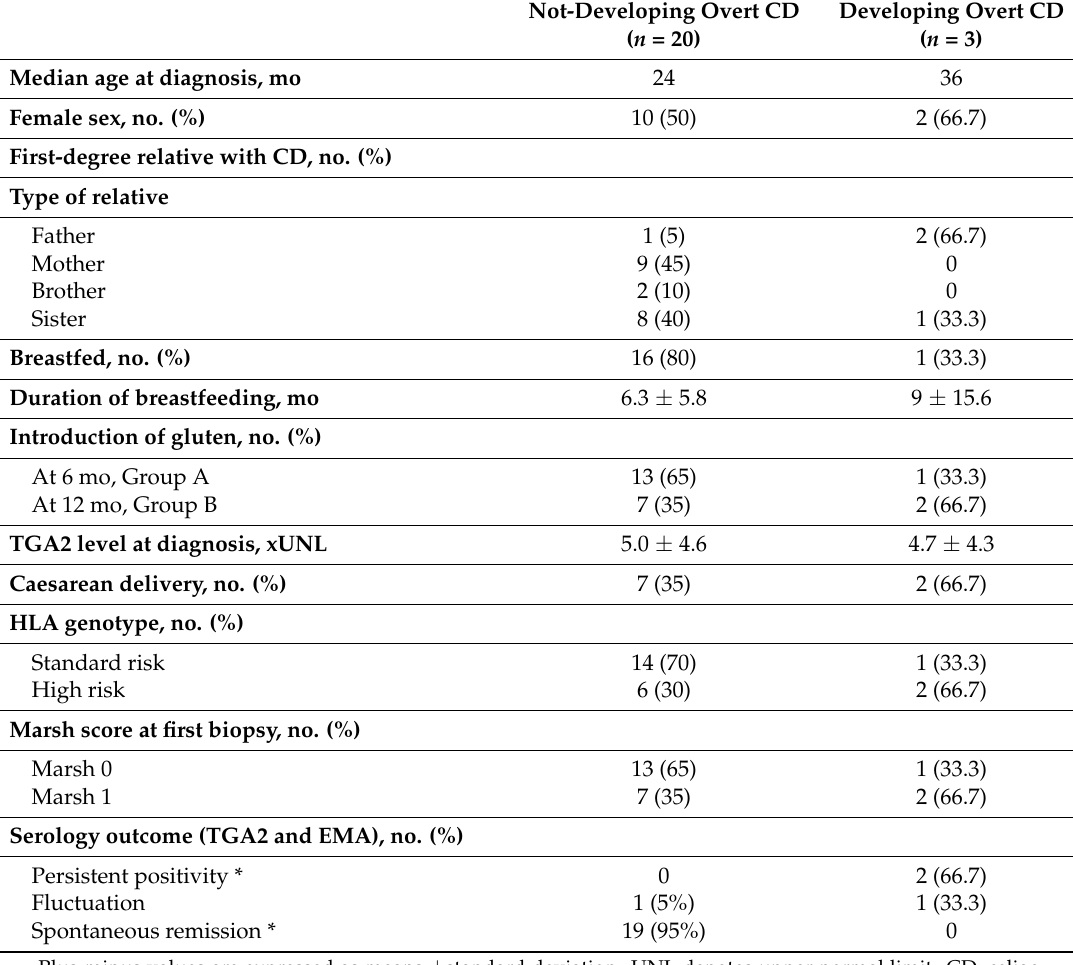
Not-Developing Overt CD Developing Overt CD ( n = 20) ( n = 3) 24